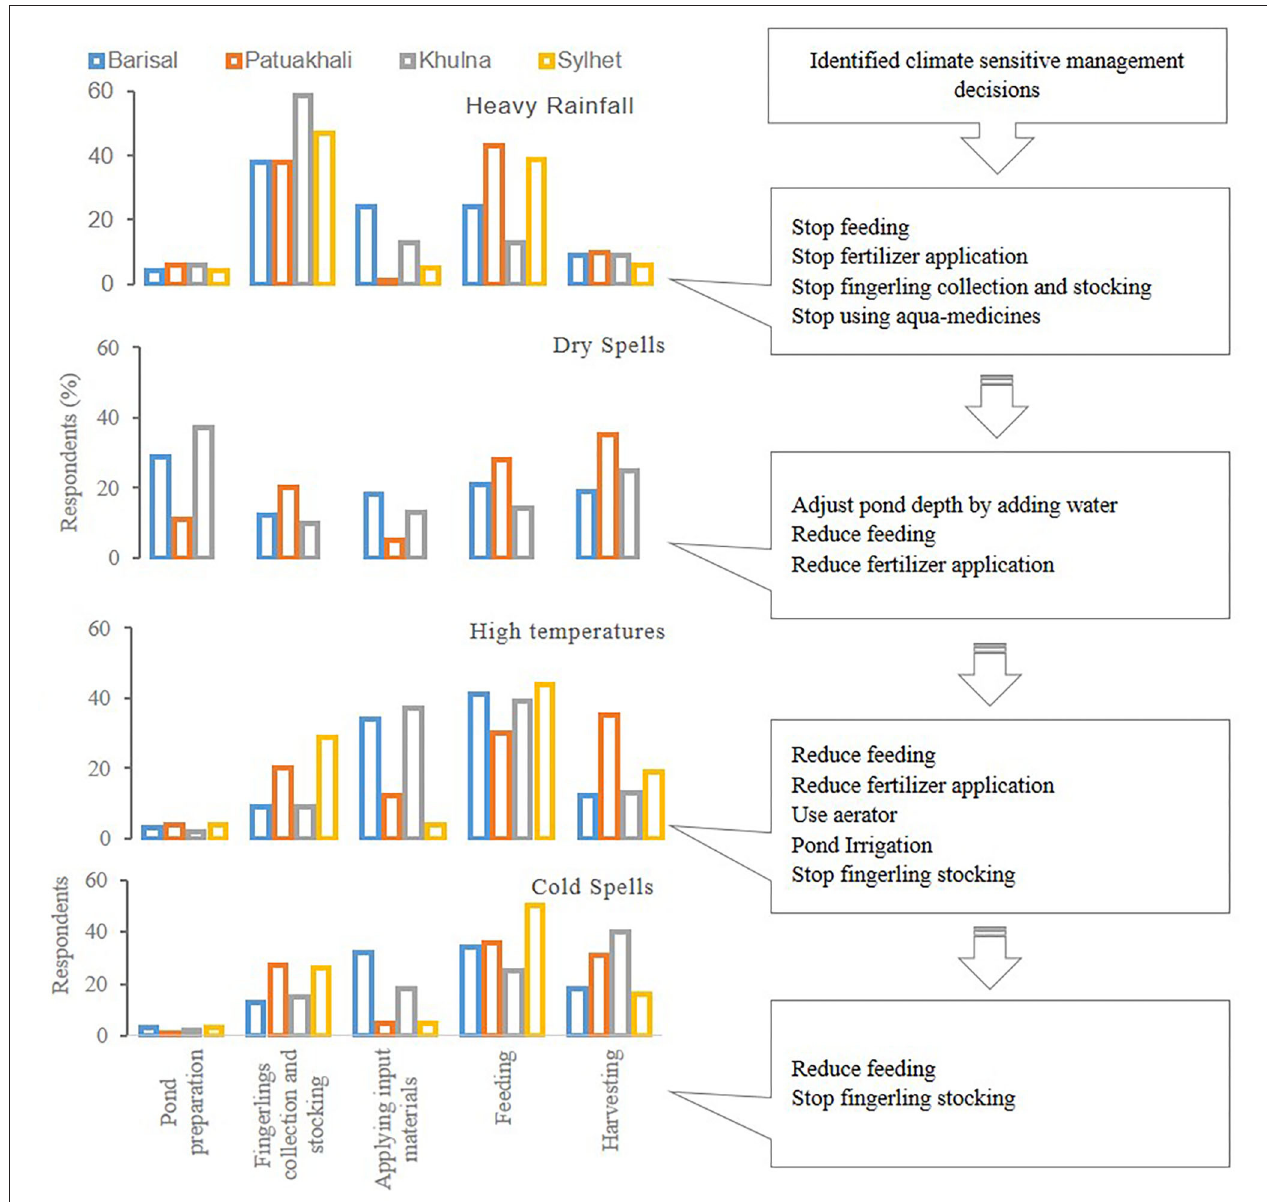
FIGURE 8 | Climate sensitive aquaculture operations identified by farmers in relation to specific types of weather events and consequent management